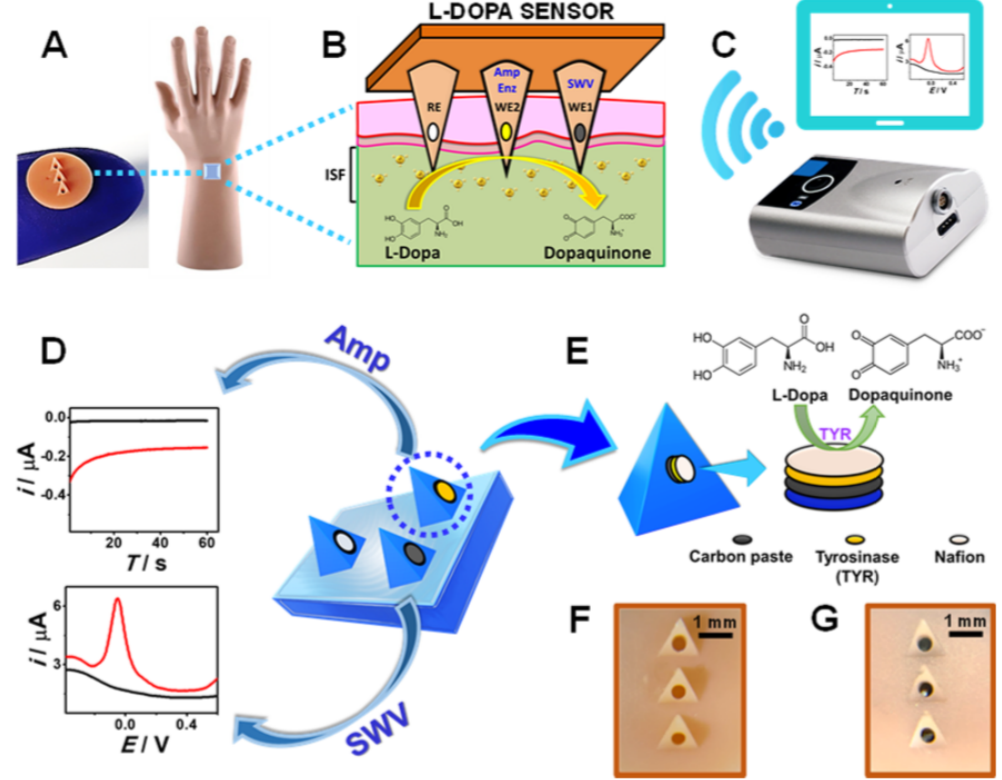
Figure 11. Schematics of the microneedle sensor array for L-Dopa detection: ( A ) microneedle sensor in a mannequin hand and ( B ) the L-Dopa sensor array. ( C ) Handheld wireless electroanalyzer for wireless data transmission. ( D ) Illustrative representation of the sensor array principle. ( E ) CP microneedle electrode, with the corresponding reagent layers: tyrosinase and Nafion. ( F , G ) Optical images of microonedles before and after assembling with CP. Reproduced with permission from Ref. [102]. Copyright 2019 American Chemical